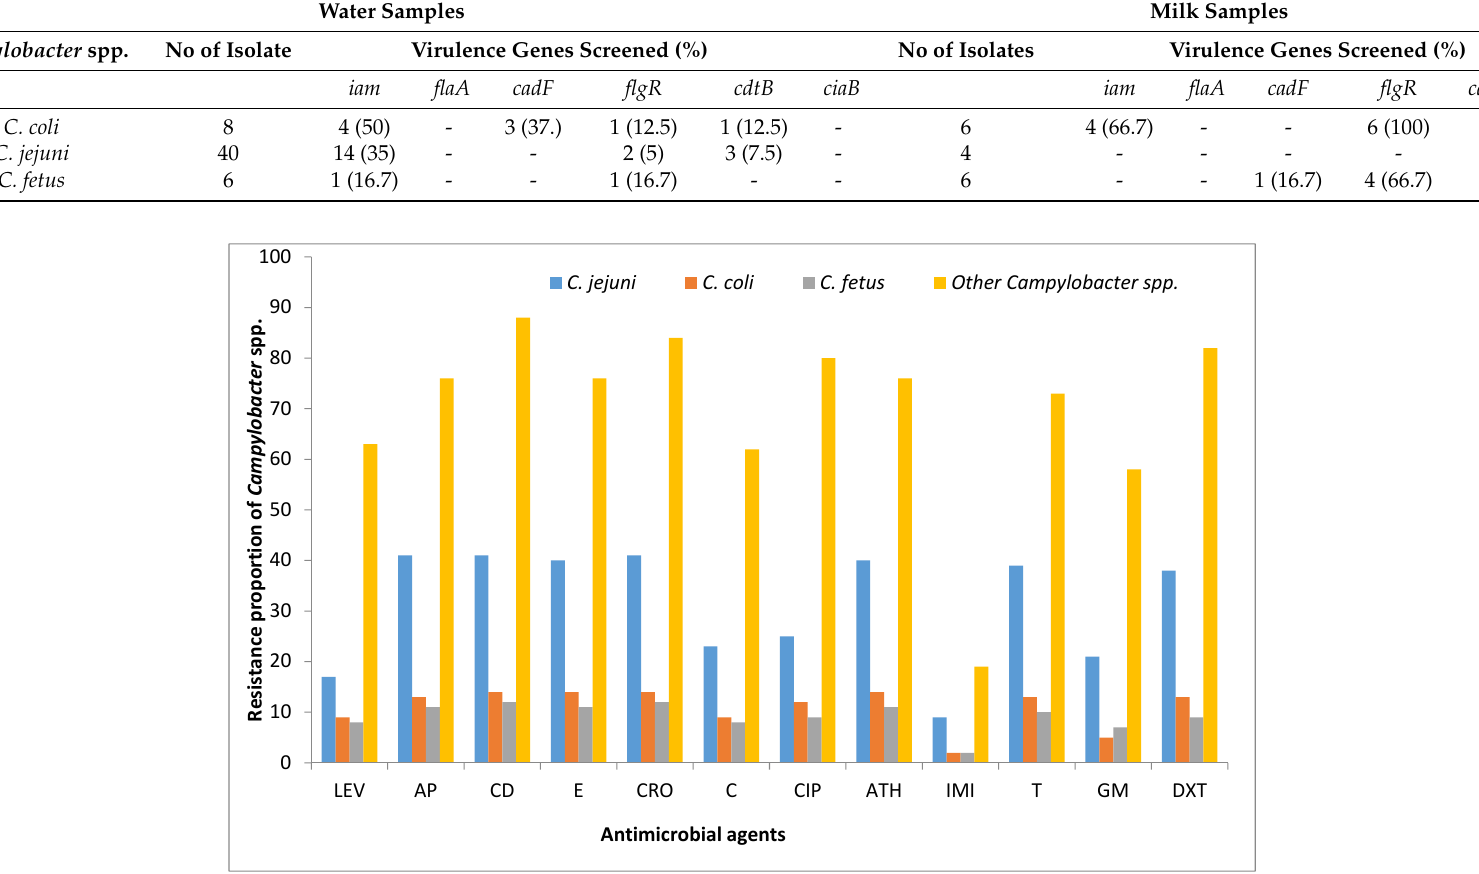
Figure 8. Resistance proportions of C . jejuni , C . coli , C . fetus and other Campylobacter species isolated from milk and water samples to 12 antimicrobial agents. Levofloxacin (LEV), ciprofloxacin (CIP), azithromycin (ATH), imipenem (IMI), ampicillin (AP), clindamycin (CD), tetracycline (TET), ceftriaxone (CRO), chloramphenicol (C), erythromycin (E), gentamicin (GM) and doxycycline